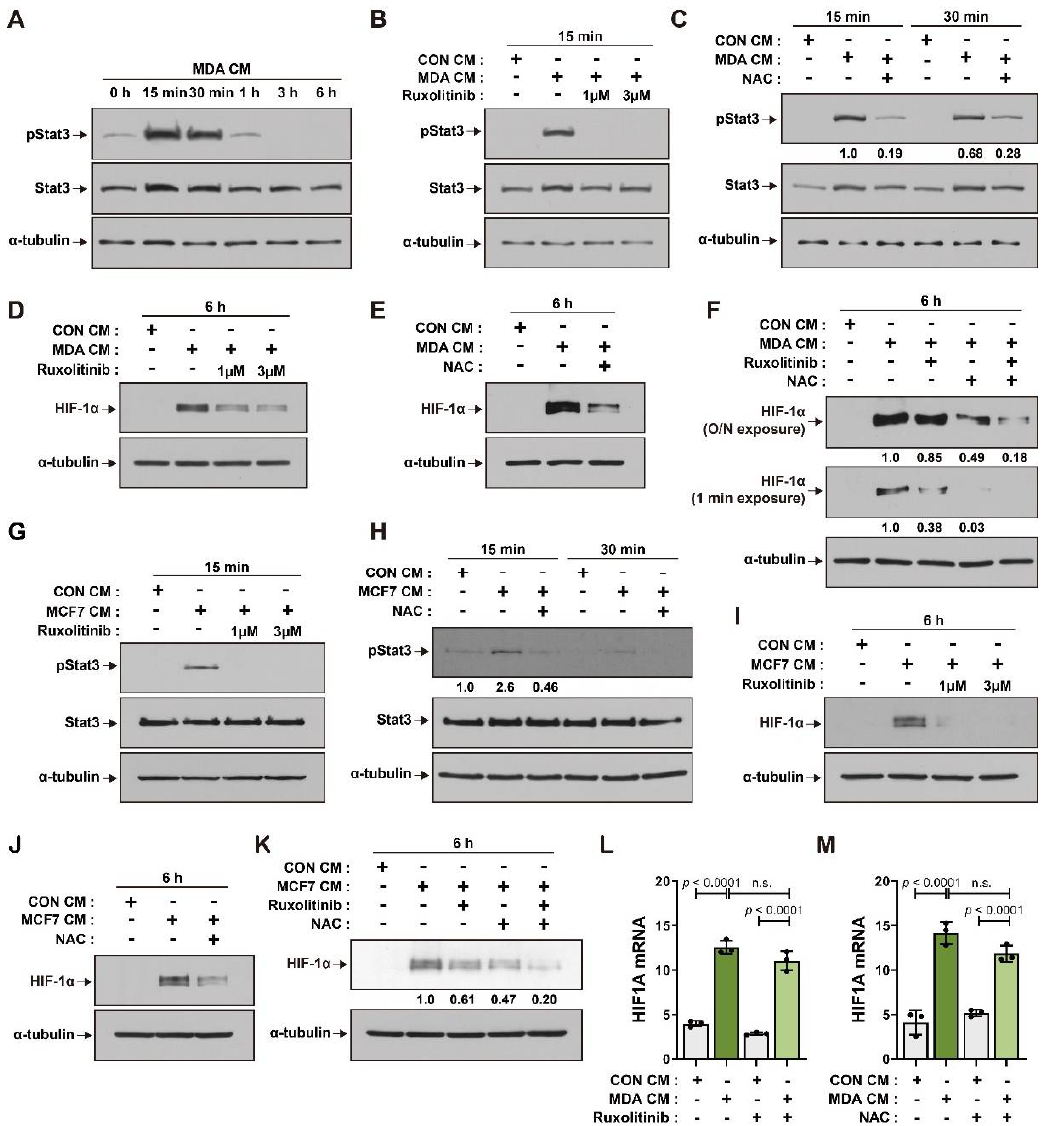
Figure 2. Increase in HIF-1α protein levels in BM-MSCs in response to breast tumor-mimicking conditions via JAK/Stat3 signaling and ROS: ( A – K ) Western blot analysis of phosphorylated Stat3 (pStat3), Stat3, and HIF-1α in BM-MSCs treated with CON CM, MDA CM, and MCF7 CM, and in BM-MSCs pretreated with ruxolitinib (1 μM or 3 μM) and/or NAC (5 mM) followed by treatment with CON CM, MDA CM, or MCF7 CM for the indicated times; α-tubulin was used as an internal control; O/N exposure = overnight exposure; the numbers under the blot represent the fold value of pStat3 normalized by Stat3 ( C , H ) and of HIF-1α normalized by α-tubulin ( F , K ). ( L , M ) qRT-PCR analysis of HIF1A mRNA expression in BM-MSCs pretreated with ruxolitinib (3 μM) and/or NAC (5 mM), followed by treatment with CON CM or MDA CM for 12 h. Results are presented as the mean ± SD. n.s.: not significant. Uncropped Western blot images are available in Figure S2.